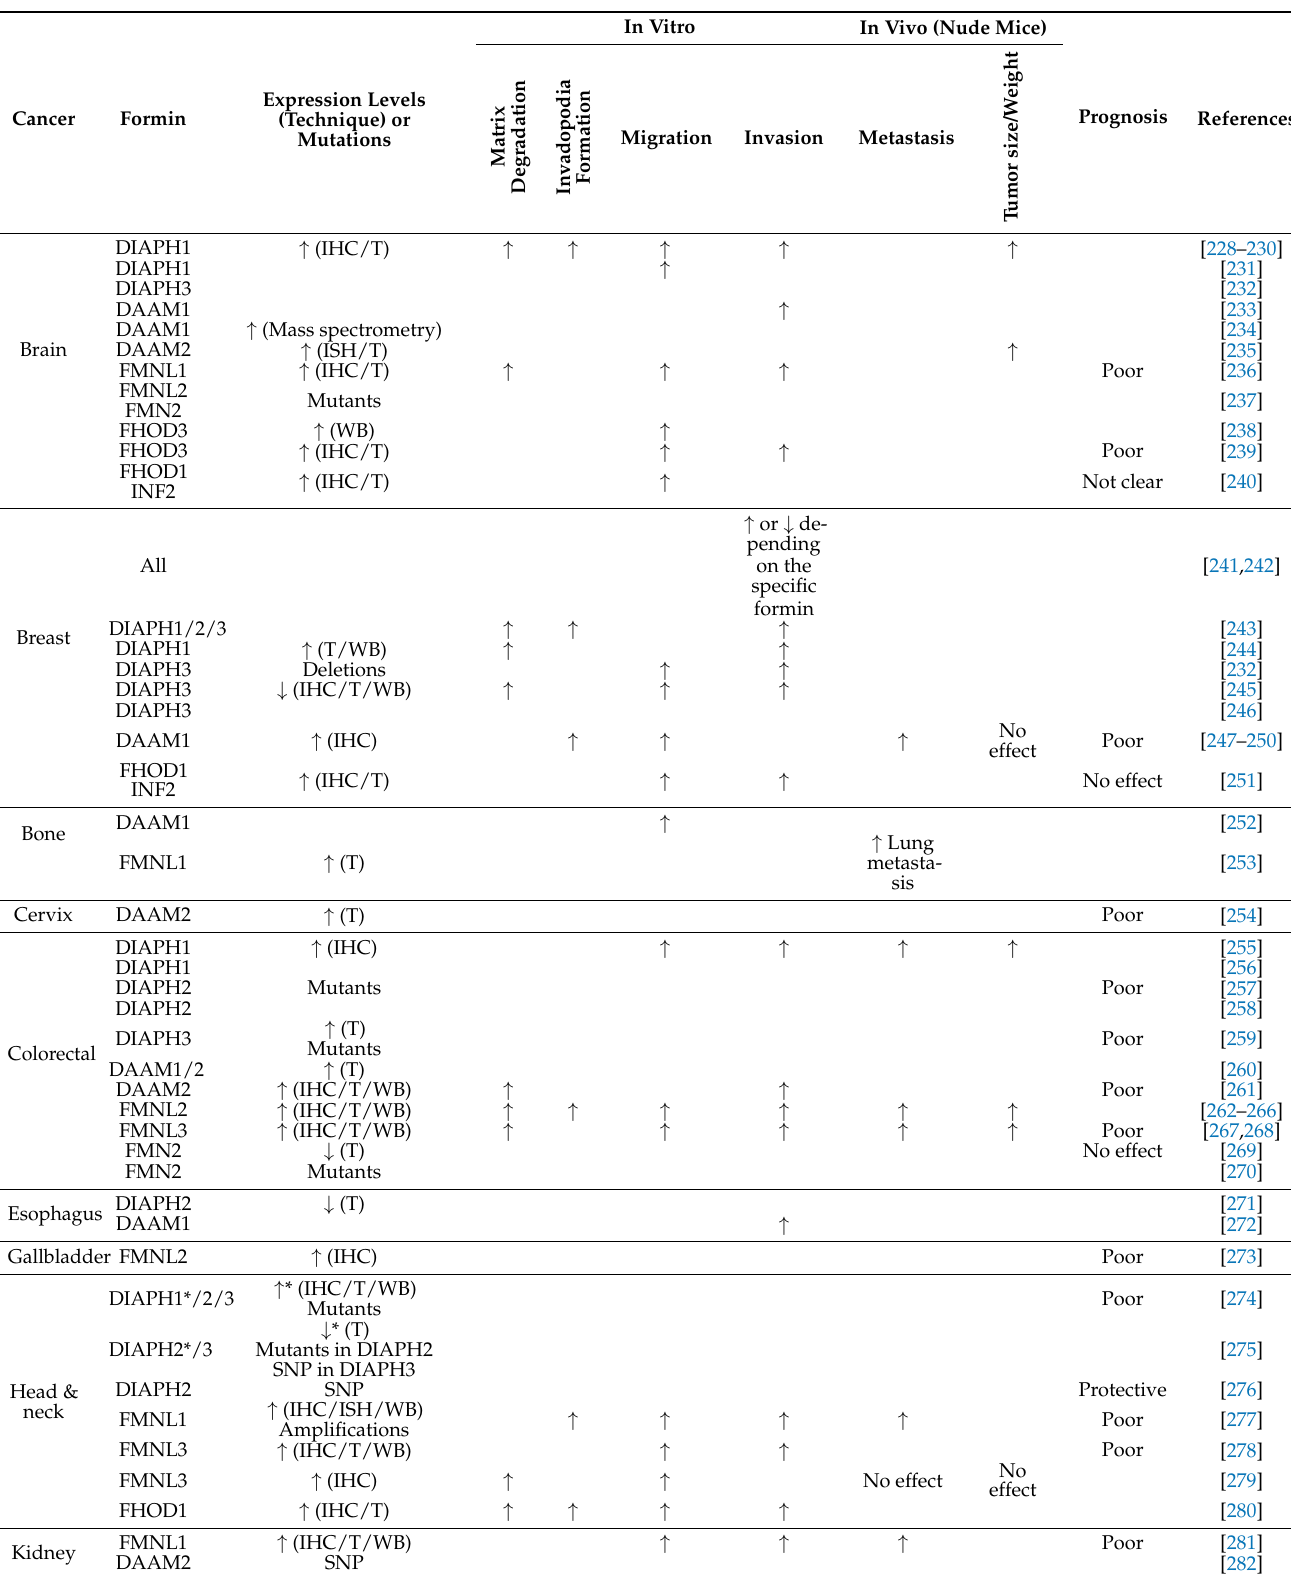
Table 1. Summary of formin expression in different types of cancer. The in vitro and in vivo experiments providing evidence of the involvement of formins in cancers and the use of formin expression as prognostic biomarkers are also summarized.